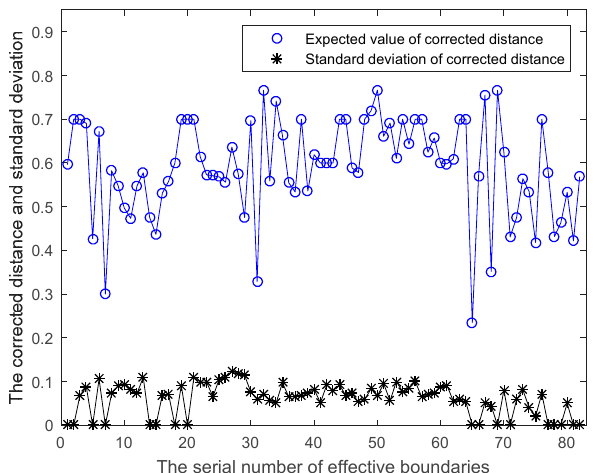
Figure 5. The corrected distances of all effective boundaries and their variances.